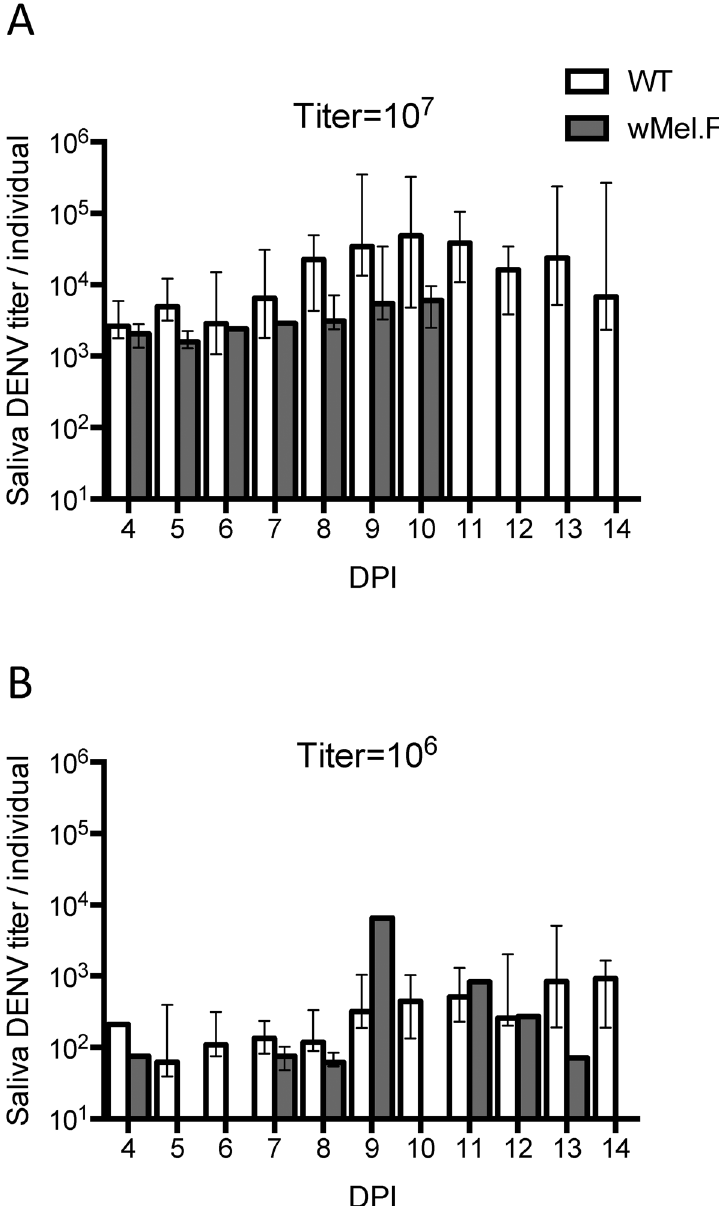
Fig 3. The DENV titer in the sucrose solution of WT (white bar) and w Mel.F mosquitoes (grey) fed on 10 7 (A) or 10 6 (B) PFU/ml of DENV. Bars depict medians ± interquartile range. DENV titer is expressed as copies per live individual to correct for